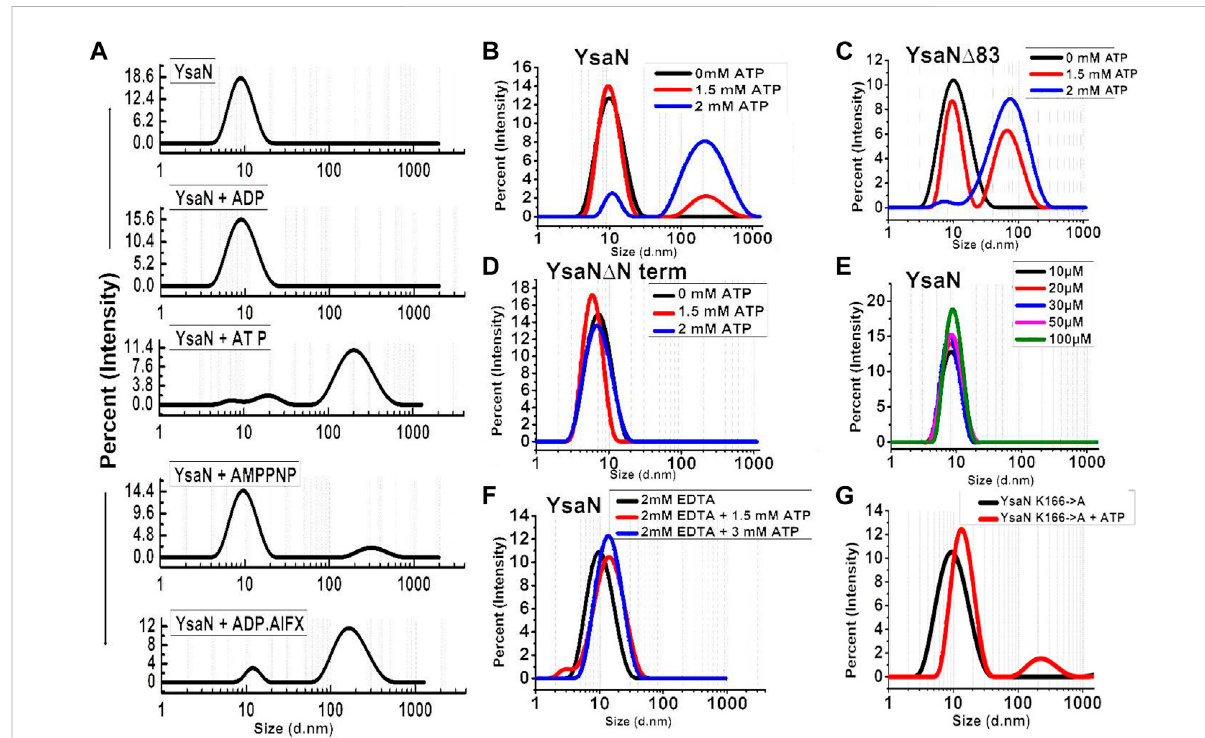
FIGURE 3 Dynamic light scattering study of YsaN oligomerization — (A) - Representation of size intensity pro fi le of YsaN and in the presence of substrates like2 mMADP(product),2 mMATP(substrate),2 mMAMPPNP(anon-hydrolyzableATPanalog),and1.5 mMADP.AlFX(anATPtoADP+Pitransition state analogue). (B – D)- Substrate (ATP) concentration-dependent oligomerization of YsaN, YsaN Δ 83, and YsaN Δ Nterm respectively demonstrating the role of YsaN N- terminal domains in YsaN oligomerization. (E)- Protein concentration-dependent DLS study of YsaN. (F)- Size intensity pro fi leofYsaN inpresenceof2 mMEDTAdemonstratingtheroleofMg 2+ dependent catalysis ofATPto ADP+Pianditsroleinoligomerization. (G)- Size intensity pro fi le of YsaN Walker-A lysine mutant YsaN K166 → A in the absence and presence of 2 mM